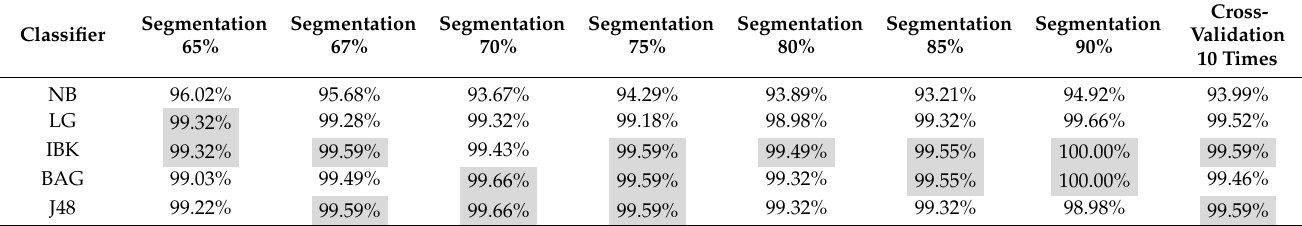
Table 14. The classifier accuracy of feature selection for 2455 normal and 491 bankrupt companies (5:1).